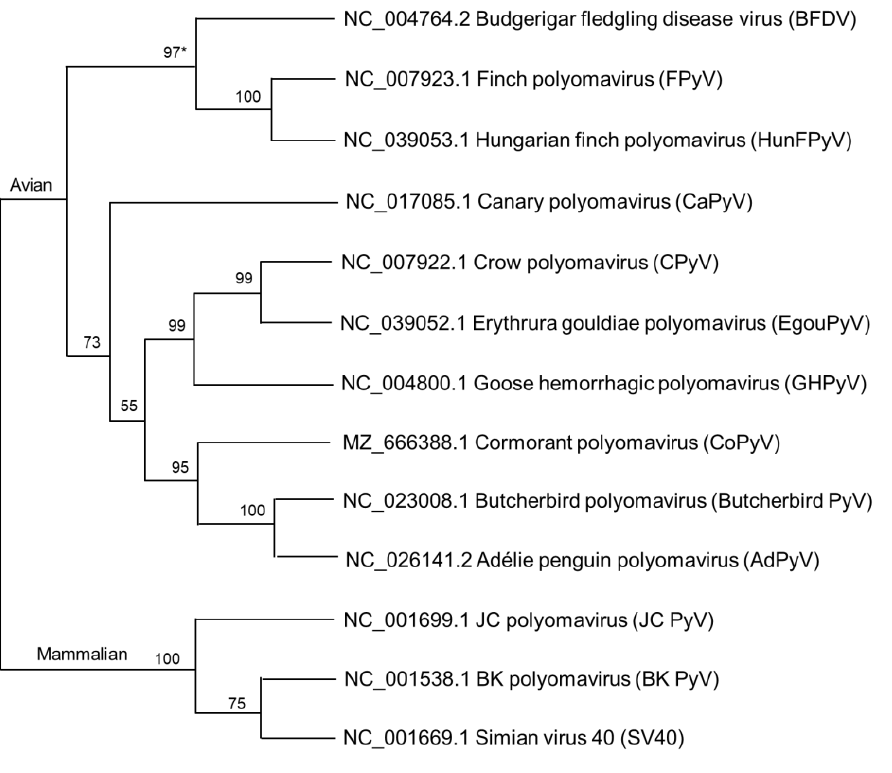
Figure 3. Phylogenetic analyses using amino acid sequences of the large T-Ag ( A ) and VP1 ( B ) from the Gammapolyomaviruses. The phylogeny, which uses the large T-Ag, can distinguish between APVs and MPVs. Interestingly, using VP1 for the analysis, Butcherbird PyV and AdPyV show the closest relationship with MPVs on a common branch. Pathogenically, their clinical symptoms are mild and there is no mortality (Table 2) [28,29]. Virus names and GenBank accession numbers are shown on the phylogenetic tree. * The bootstrap value on the branch represents the percentage while using 1000 bootstrap replicates.